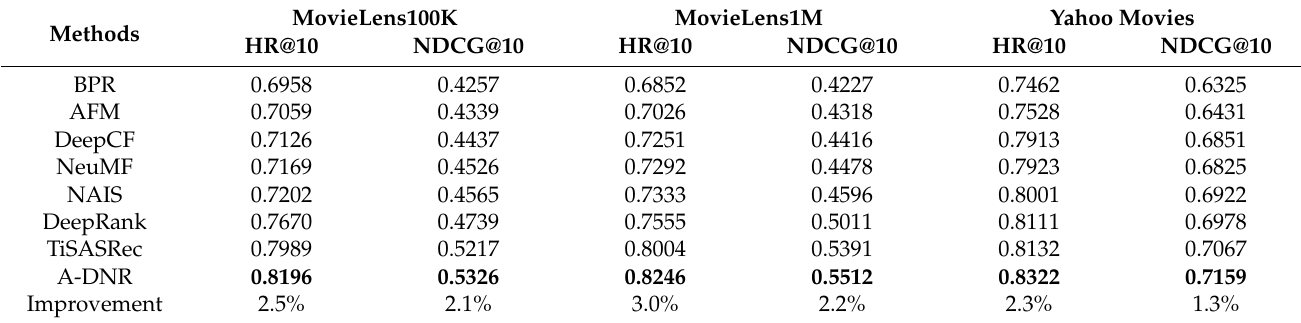
Table 2. Performance comparison of different comparison